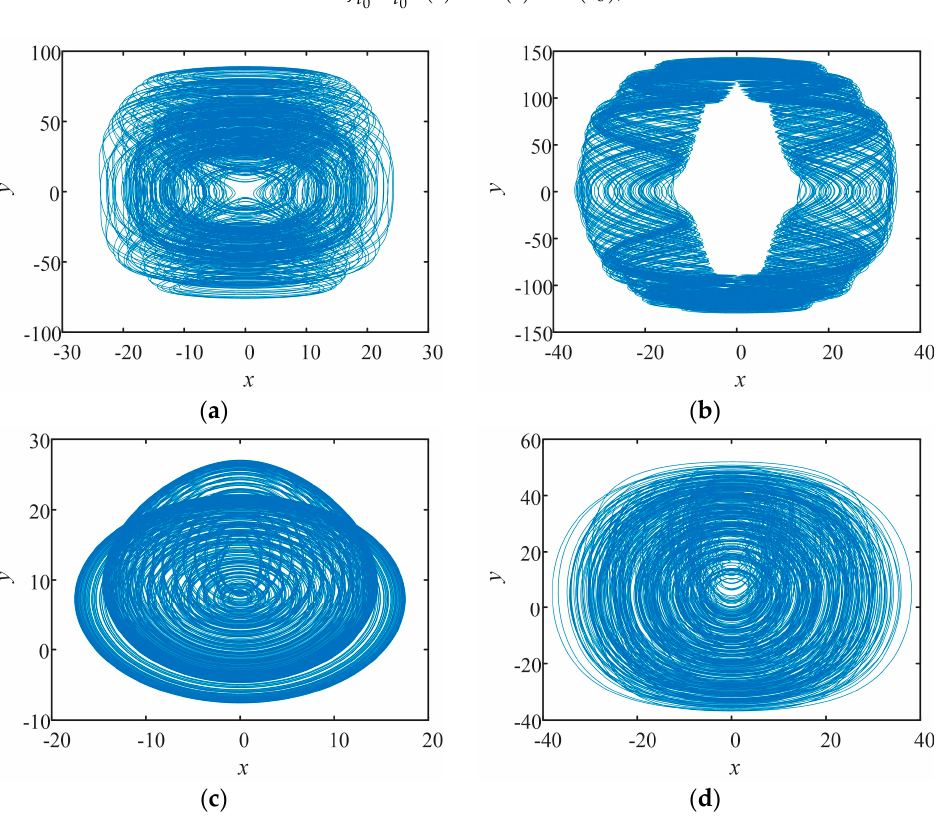
Figure 4. Phase diagram of the chaotic attractor. ( a ) a = 2, b = 11, c = 20, d = 10, e = 1; ( b ) a = 2, b = 20, c = 10, d = 10, e = 13; ( c ) a = 0.3, b = 11, c = 20, d = 10, e = 30; ( d ) a = 0.3, b = 11, c = 20, d = 10, e = 50.